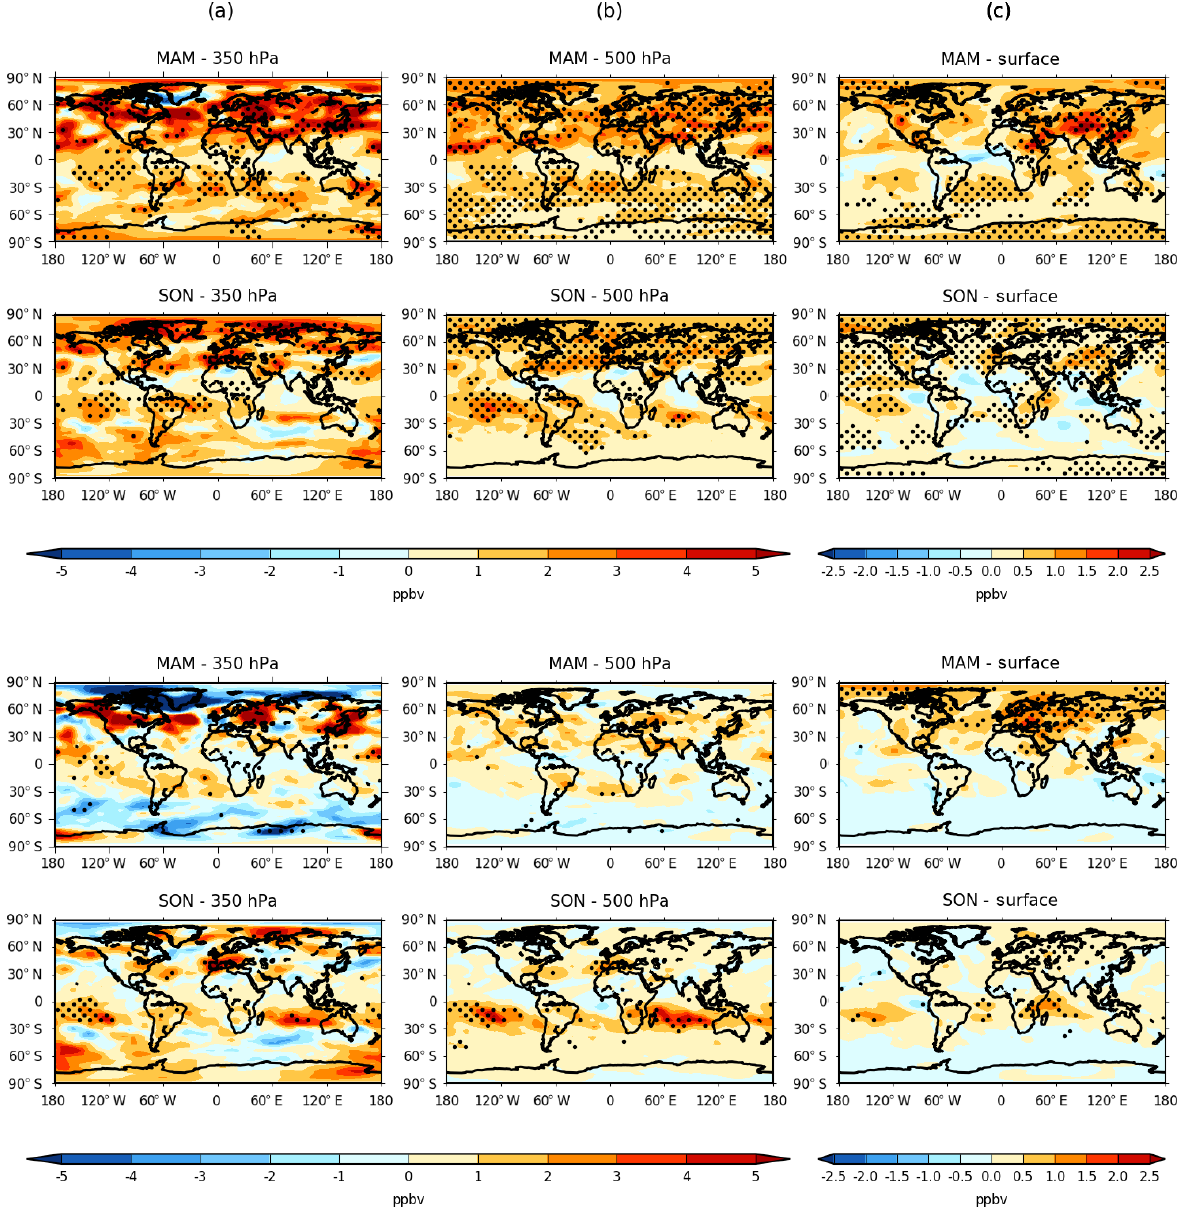
Figure 10. Seasonal change in EMAC (top) and CMAM (bottom) stratospheric ozone (O 3 S) VMR (ppbv) between 1980–1989 and 2001– 2010 for MAM and SON at (a) 350hPa, (b) 500hPa and (c) the surface model level. Stippling denotes regions of statistical significance according to a paired two-sided t test ( p < 0 . 05). Note the scale difference between (a–b) and (c)